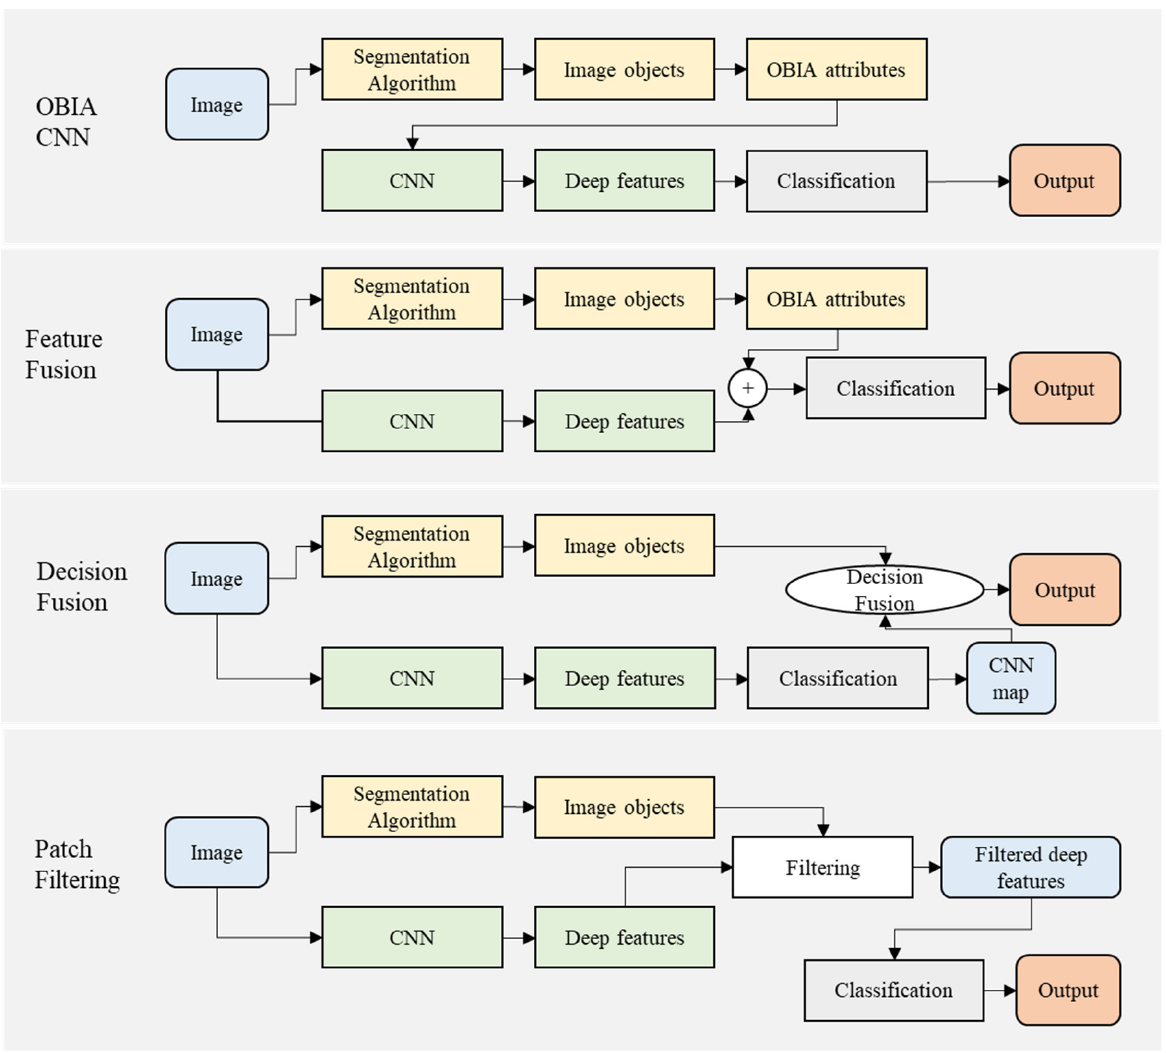
Figure 5. ANN architecture used in integrated OBIA-deep learning frameworks.